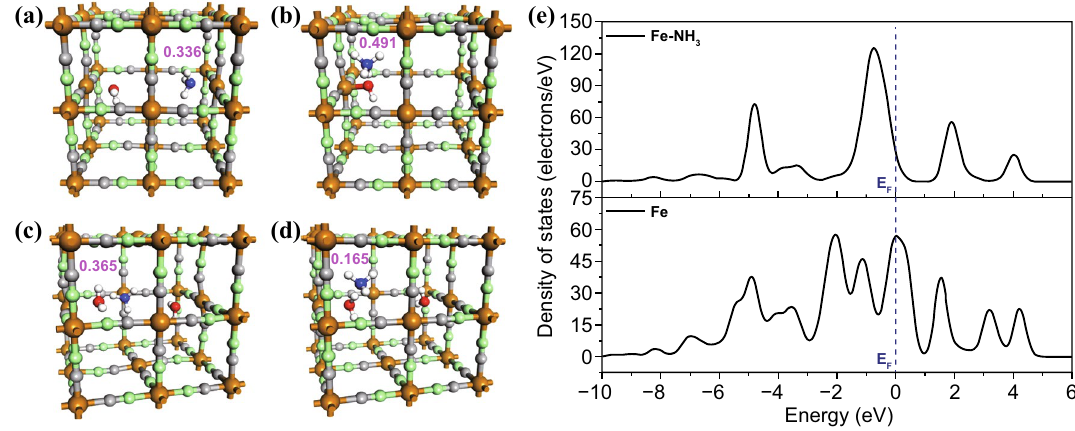
Fig. 2 Atomic structures of ammonia molecule inserted into BG lattice: a , b vacancy site and interstitial site for Fe[Fe(CN) 6 ] 0.75 ·H 2 O, and c, d vacancy site and interstitial site for Fe[Fe(CN) 6 ] 0.75 ·2H 2 O (the number in red is the total Mulliken Charge of absorbed ammonia molecule); e DOS patterns of 3d orbital of face-centered Fe atom before and after ammonia absorption of panel